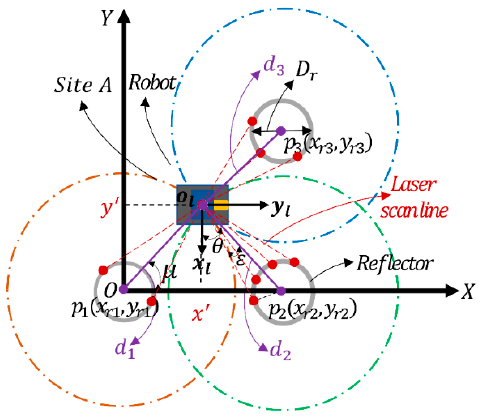
Figure 4. Extraction of reflectors and localization based on the three-sided measurement.